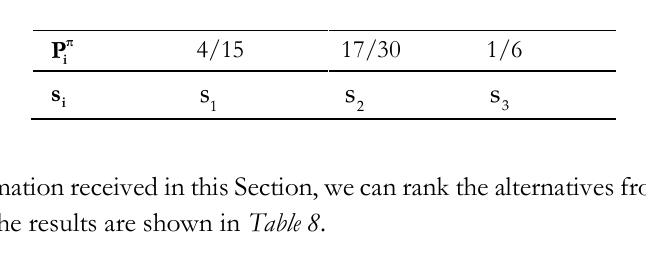
Table 7. Shapley Indexes of the possibility distribution.